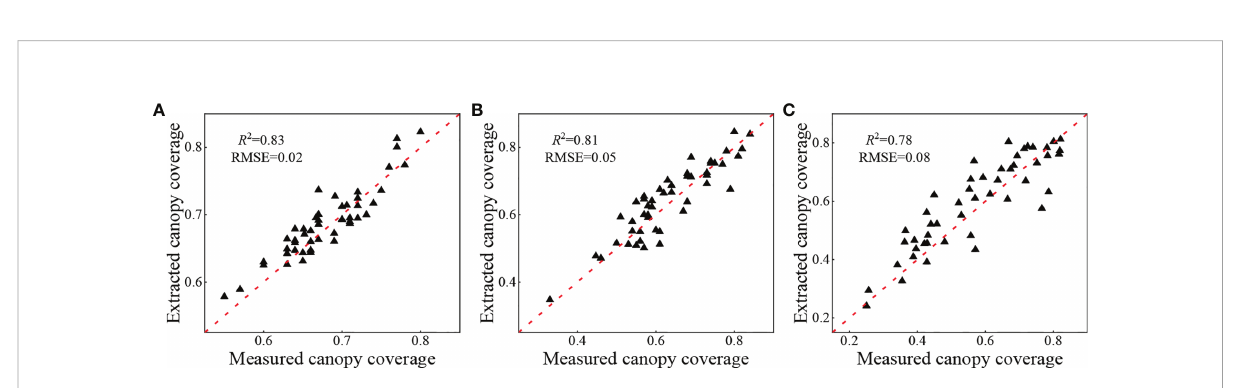
FIGURE 5 Comparative analysis of potato extraction coverage and measured coverage at (A) S1, (B) S2, (C) S3.